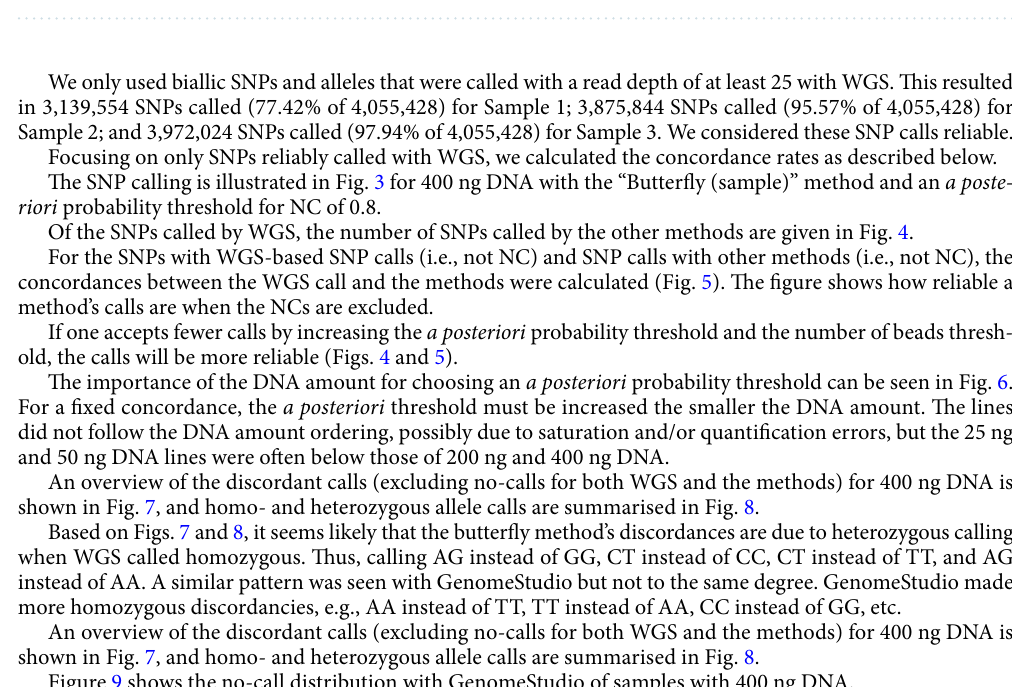
Figure 1. The densities of the numbers of beads for both probe types I and II from three individuals. There is one curve for each probe type and dilution, 10 in total. The densities are almost similar. The interval [5, 23] is the middle 95% of the probability mass for both probe types and all dilutions. Hence, 95% of the probes were expected to have between 5 and 23 beads. The median number of probes for both probe types and all DNA concentrations was